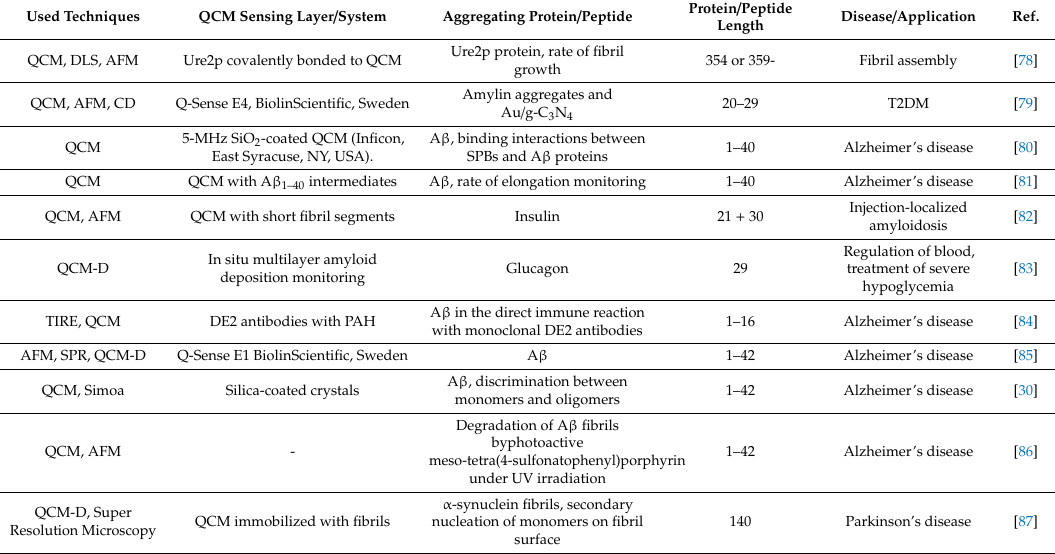
Table 1. A selection of some QCM applications connected with formation of extracellular amyloid deposits or intracellular inclusions with amyloid-like